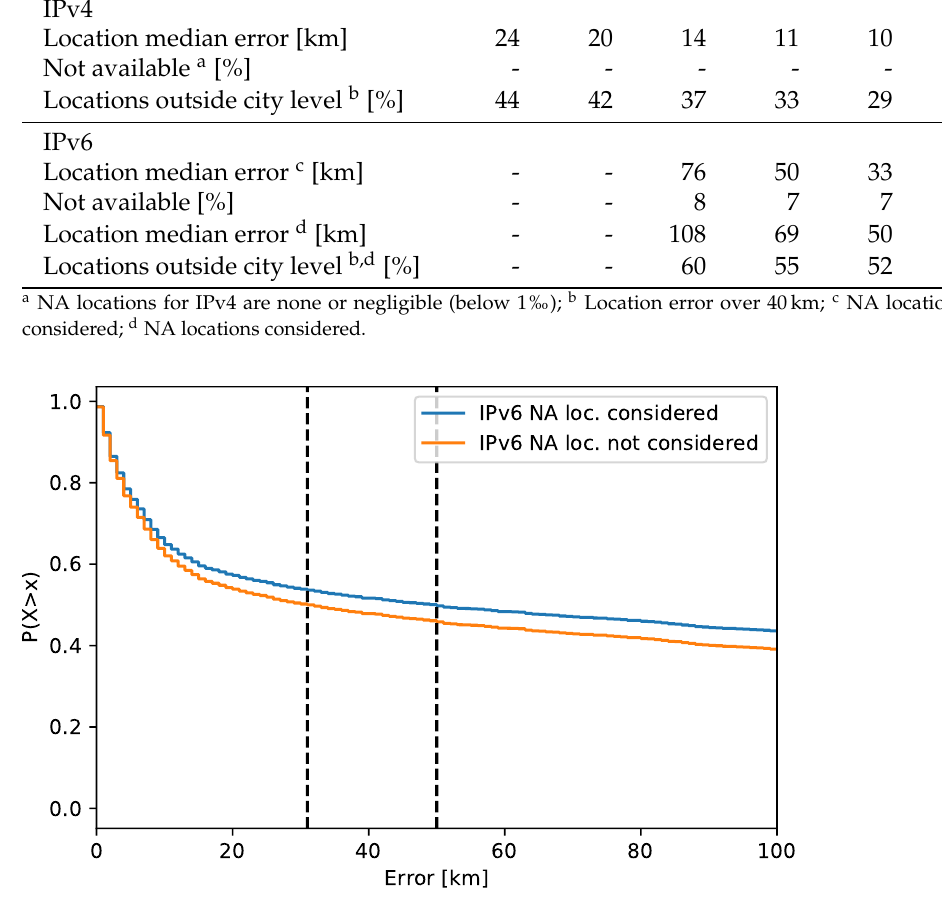
Figure 5. Effect of NA locations substituted by the maximal error observed for the ground truth in